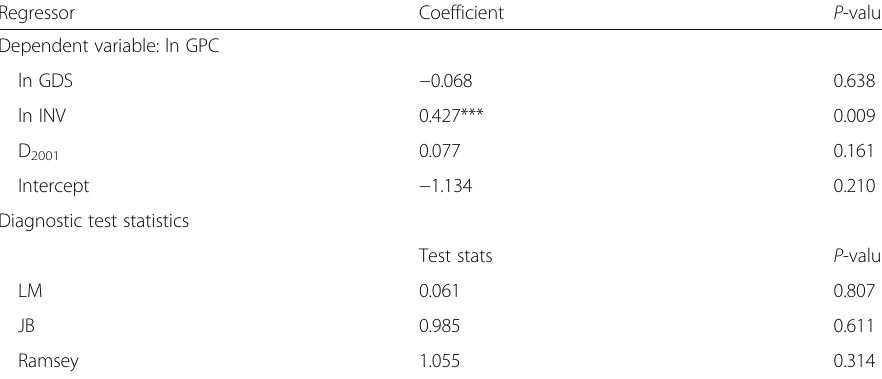
Table 6 ARDL model: Long-run